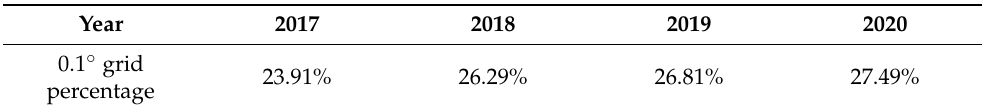
Table 1. Percentage of gridded global ocean area fished in 2017–2020. Note that each grid is considered to contain effort regardless of the actual effort (hours) or the number/type of vessels or fishing gear within the grid (see discussion of Kroodsma et al. [22]).